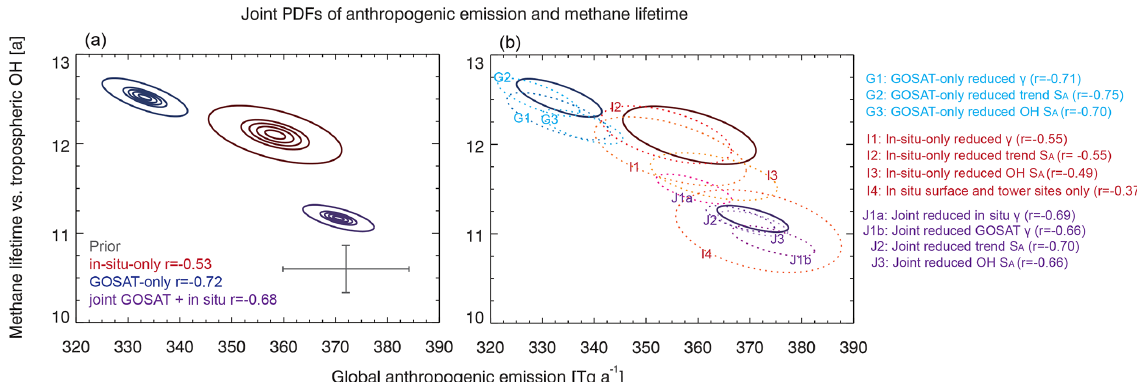
Figure 13. Joint probability density functions (PDFs) of global mean anthropogenic methane emission and methane lifetime against oxi- dation by tropospheric OH optimized by different inversions. Panel (a) shows the results from the prior and the three base inversions. The prior estimates are shown in gray with bars representing the prior error standard deviation. The thick contours show probabilities of 0.99 (outermost), 0.7, 0.5, 0.3, and 0.1 (innermost). The error correlation coefficients are given inset. Panel (b) shows the 0.99 probability contours from the three base inversions along with the same contours for 10 additional sensitivity inversions using reduced values of the regularization parameter γ (0.05 instead of 0.1 for GOSAT and 0.5 instead of 1 for in situ); reduced errors for the methane emission trends on the 4 ◦ × 5 ◦ grid (5%a − 1 instead of 10%a − 1 ); reduced errors on annual hemispheric mean OH concentrations (5% instead of 10%); or surface and tower data only in the in-situ-only inversion. Table 3. Optimized global methane budget, 2010–2017. Inversions In-situ-only GOSAT-only GOSAT + in situ inversion